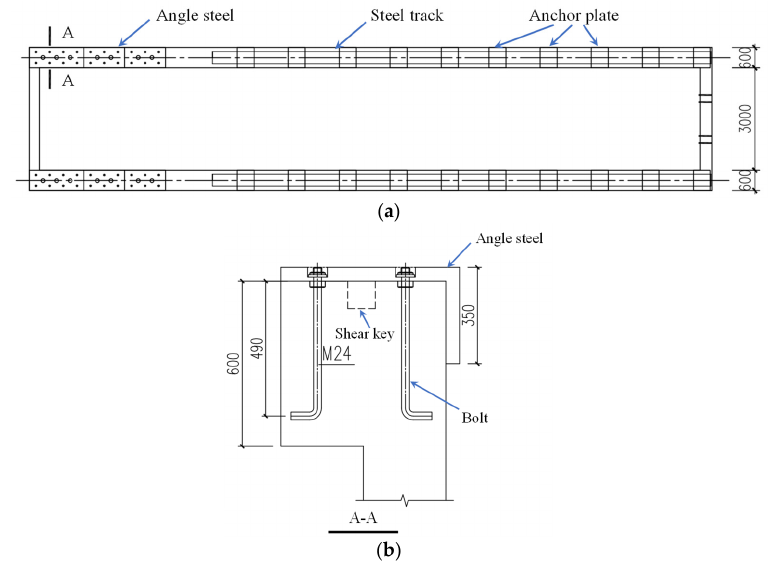
Figure 3. Plan view of the soil tank ( a ) arrangement of angle steels and steel tracks and ( b ) connection between steel angle and soil tank.